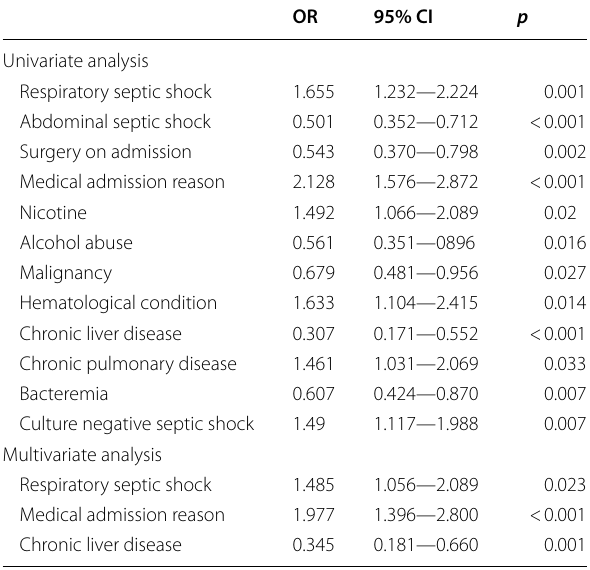
Table 3 Univariate and multivariate analysis of variables associated with exclusion from the Sepsis-3 definition of septic shock OR 95%